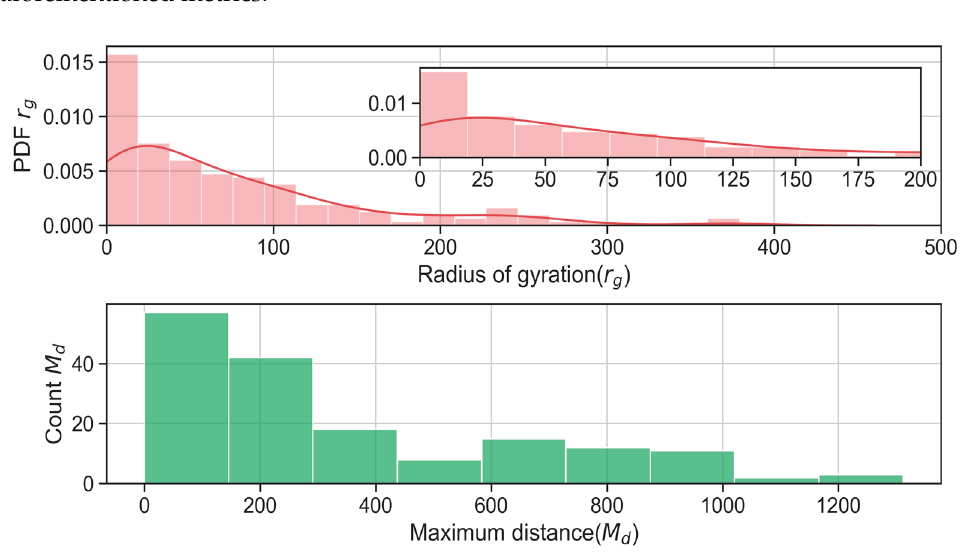
Figure 5. Radius of gyration and distance travelled by users for ParticipAct data set. The distribution of r g peaks around 25 km, which indicates that, on average, users tend to travel in a radius of 25 km from their centre of mass, e.g., their home location. Moreover, the ParticipAct users mainly take trips at a maximum of 0–100 km from their home location, as reported in the histogram of M d .